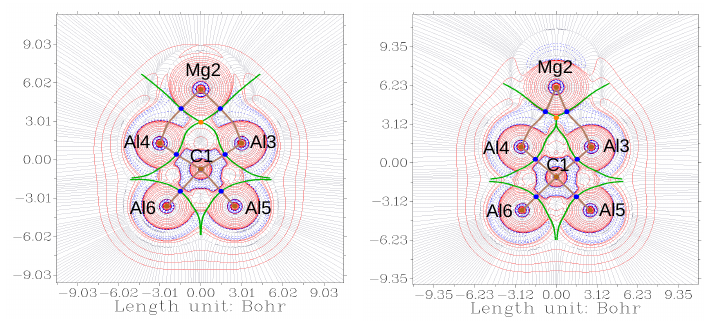
Figure 8. Contour map of the Laplacian of Electron Density ( ∇ 2 ρ (r)) with the bond paths for CAl ( 1n ) and CAl 4 Mg − ( 1a ) calculated at the (U) ω B97XD/6-311++G(2d,2p) level. The blue lines show areas of charge concentration ∇ 2 ρ (r) ≤ 0, whereas the red lines show areas of charge depletion δ 2 ρ (r) ≥ 0. The brown dots represent the nucleus critical point or NCP. The brown lines connect NCP and bond critical points (BCP). The green line connecting RCP (ring critical point, orange dot) shows the inter-basin path. For clarity, the atomic label and index are added nearby the position of the corresponding